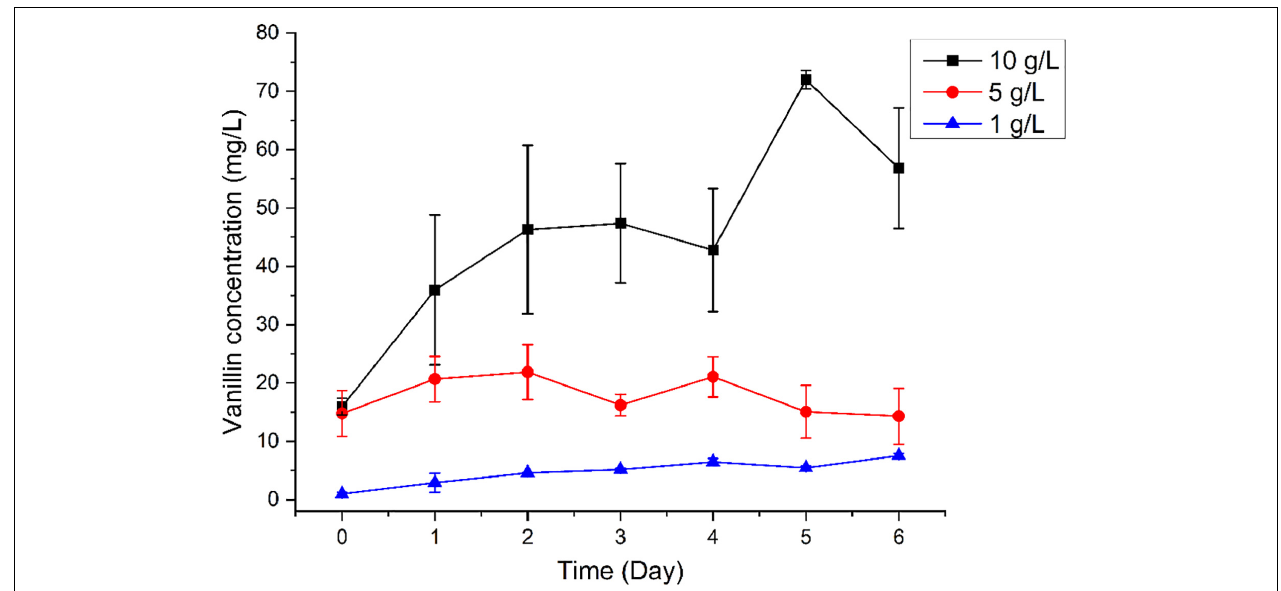
FIGURE 2 | Time-course analysis of vanillin production using different concentrations of bio-oil as the